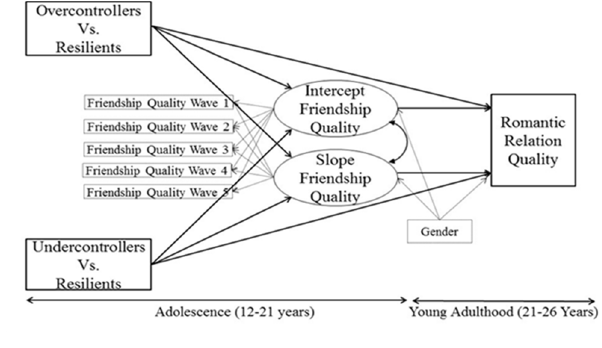
Figure 1. Structural Equation Model Testing the Relations between Adolescent Personality Types, Adolescent Friendship Quality Development, and Young Adulthood Romantic Rela- tionship